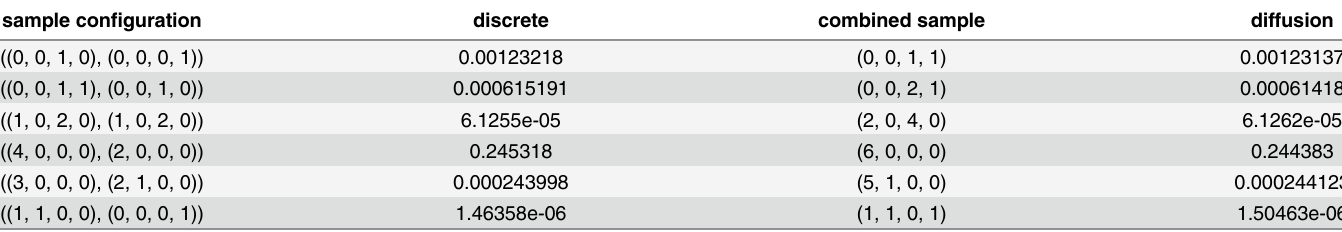
Table 1. Comparison of estimated and expected probabilities for the scenario ( q 1 , q 2 ) = ( ξ 1 , ξ 2 ).